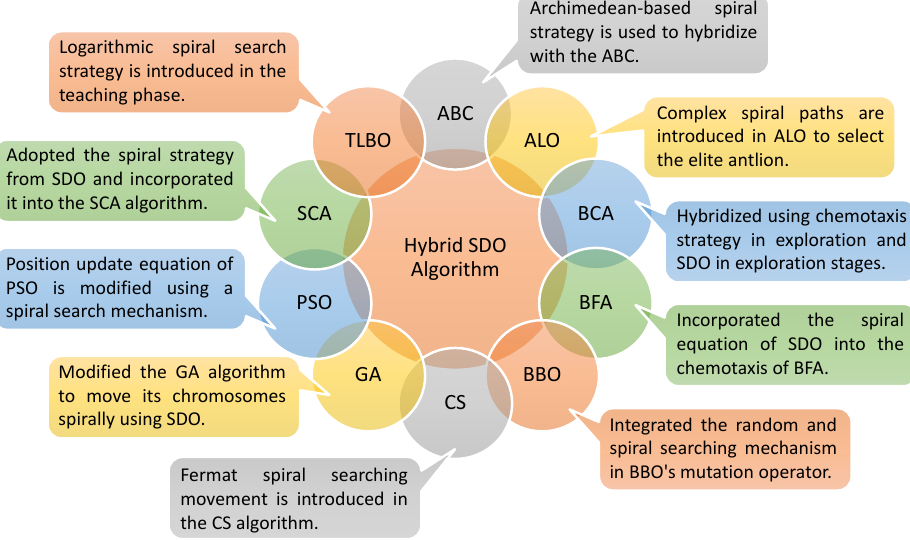
Figure 7. Hybrid versions of the SDO